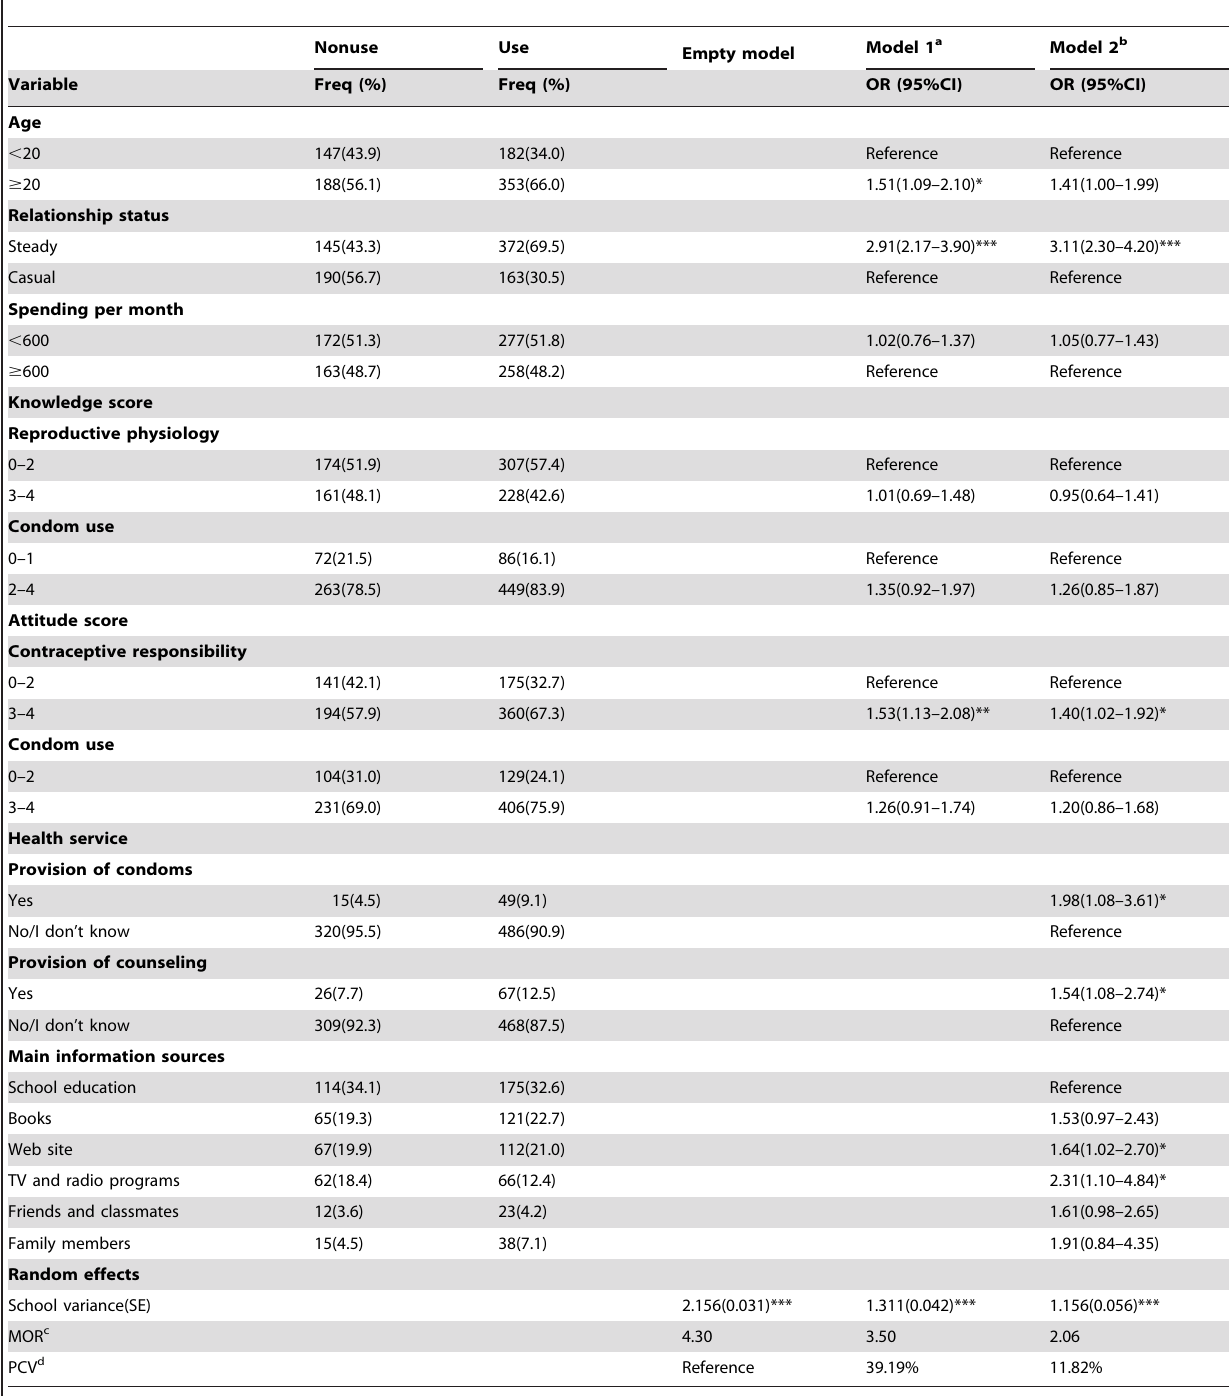
Table 4. Associations between individual reproductive health knowledge, attitude factors, health services, main information sources and condom use among sexually active male